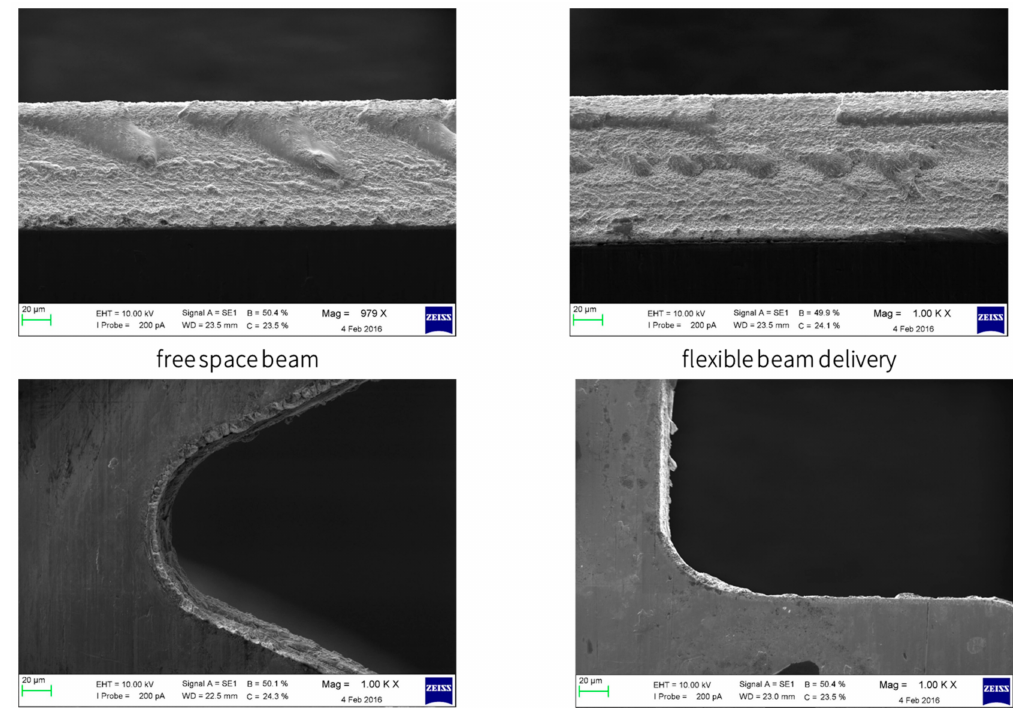
Figure 8. Comparison of cutting results. Free-space beam delivery on the left and fiber beam delivery on the right (in co-operation with femtos GmbH).